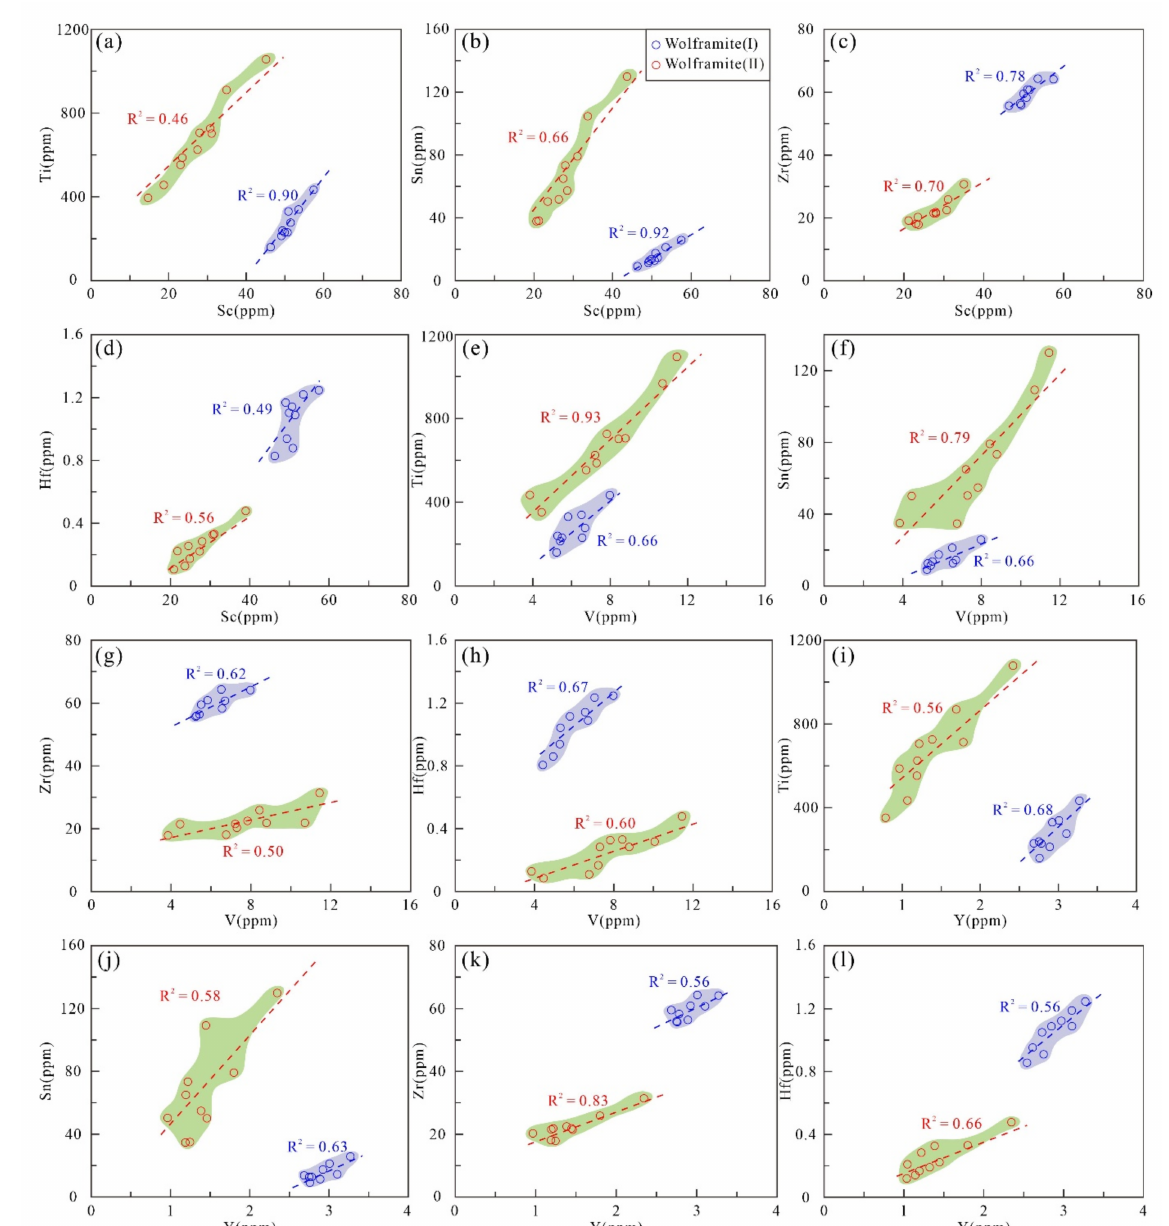
Figure 13. Correlation plots of trivalent and tetravalent cations in two generations of wolframite from the Baishitouwa deposit. ( a ) Correlation plots of Sc and Ti contents; ( b ) Correlation plots of Sc and Sn contents; ( c ) Correlation plots of Sc and Zr contents; ( d ) Correlation plots of Sc and Hf contents; ( e ) Correlation plots of V and Ti contents; ( f ) Correlation plots of V and Sn contents; ( g ) Correlation plots of V and Zr contents; ( h ) Correlation plots of V and Hf contents; ( i ) Correlation plots of Y and Ti contents; ( j ) Correlation plots of Y and Sn contents; ( k ) Correlation plots of Y and Zr contents; ( l ) Correlation plots of Y and Hf